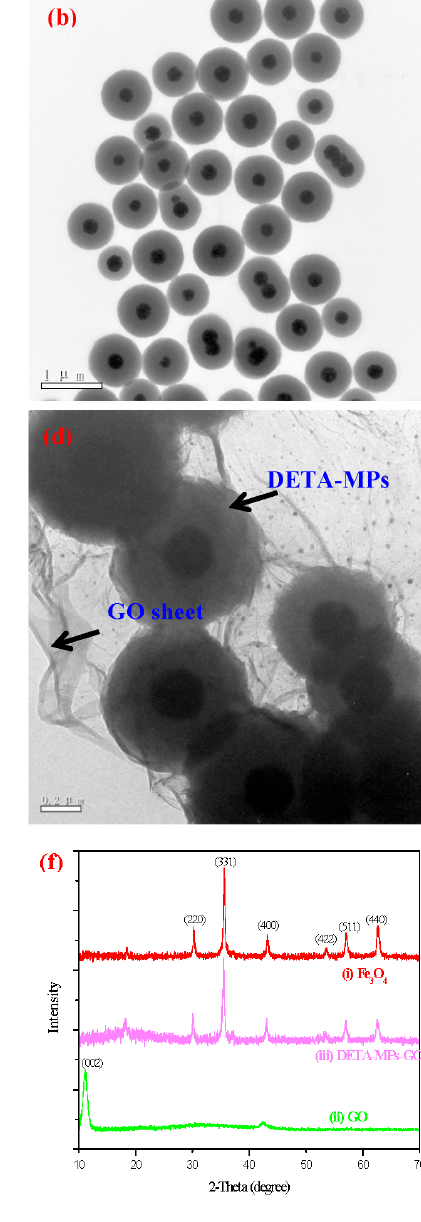
Figure 1. Transmission electron microscopy (TEM) images of: ( a ) magnetic Fe 3 O 4 microspheres; ( b ) magnetic core-shell polymer (Fe 3 O 4 @poly(GMA- co -DVB)); ( c ) DETA-MPs; ( d ) DETA-MPs-GO; ( e ) Fourier-transformed infrared spectroscopy (FTIR); and ( f ) X-ray diffraction (XRD) spectra of synthesized materials. EDTA-MPs: diethylenetriamine-functional magnetic core-shell polymer, GO: graphene